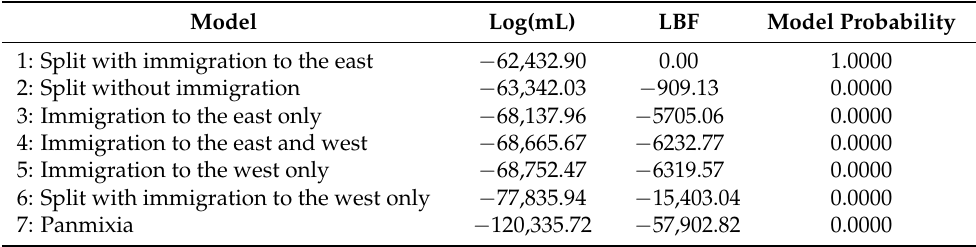
Table 2. Models of demographic history specified for the Florida panhandle/peninsula divergence tested in Migrate . The null hypothesis (and simplest case) is that sampled ponds belong to a single panmictic population (Model 7). The best model (shown in bold) has log Bayes factor (LBF) of 0.0 because the best model is used as a reference in Migrate.